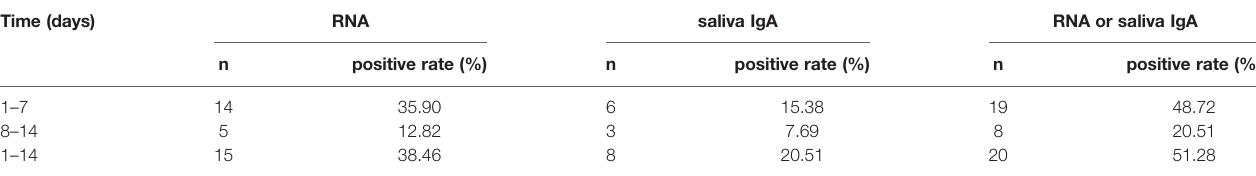
TABLE 4 | Positive detection rate of SARS-CoV-2 nucleic acid and saliva IgA at different time periods. Time (days)